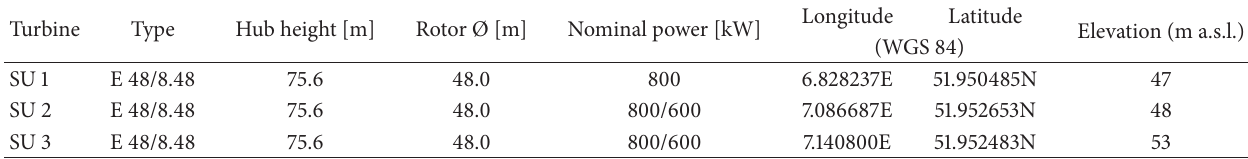
Table 6: Coordinates and data of the wind turbines at the site Suedlohn.